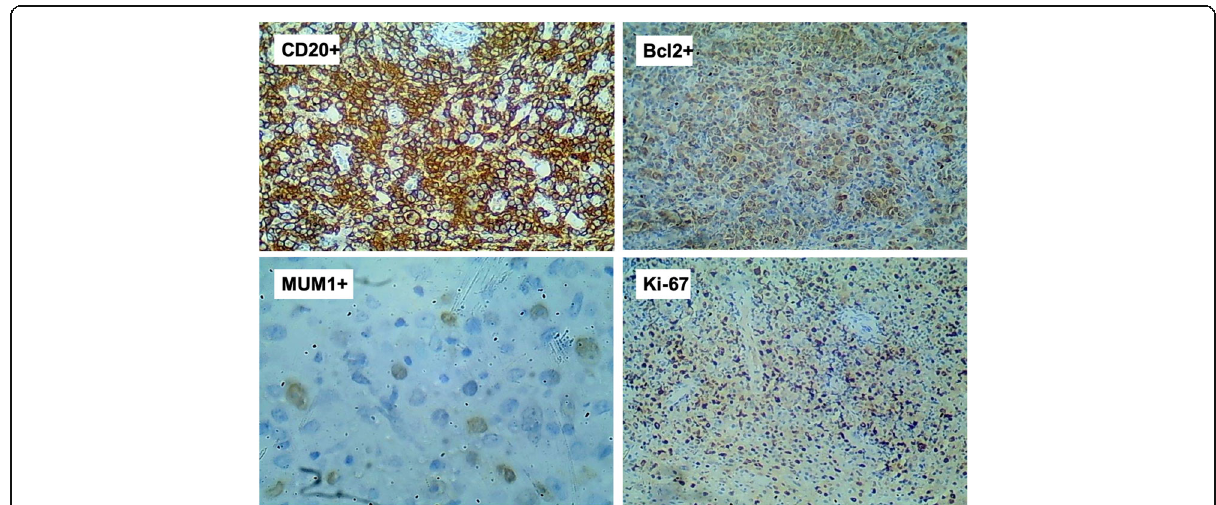
Fig. 4 Immunohistochemistry of the atypical cells positive for CD 20, bcl-2, MUM-1 and Ki-67 index of 80%